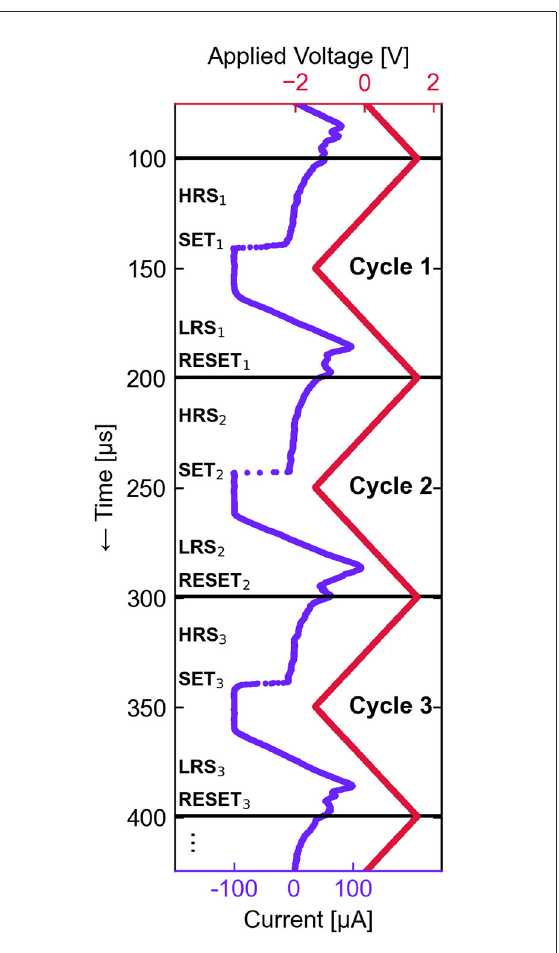
FIGURE4 Measured time dependence of I and U waveforms resulting from the ReRAM cycling experiment. The waveforms are divided into 10 6 indexed cycles, the first three of which are shown. From this dataset, the periodic temporal sequence of the states and events of each cycle (HRS n , SET n , LRS n , RESET n ) is extracted and subject to statistical modeling.